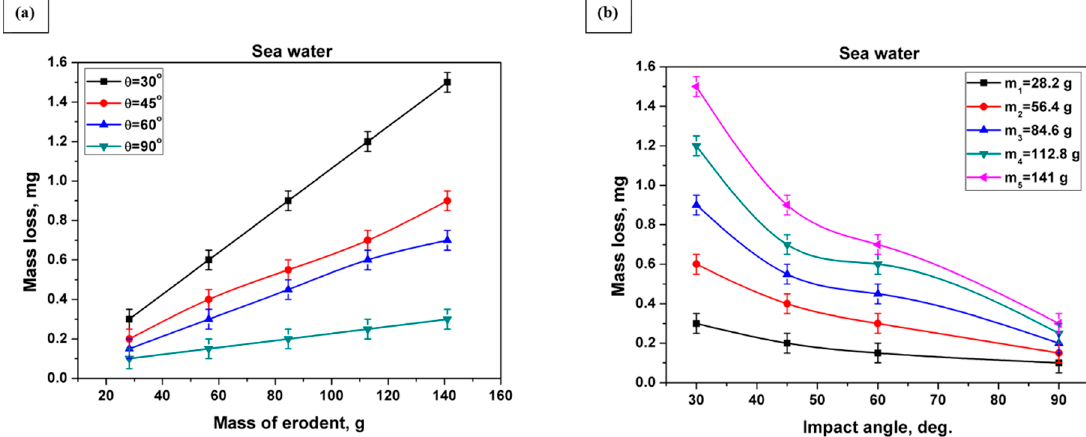
Figure 9. Mass loss of the SLMed Ti-6Al-4V alloy due to slurry erosion in seawater at impact angles 30°, 45°, 60°, and 90°: ( a ) mass loss versus mass of erodent; ( b ) mass loss versus impact angle.